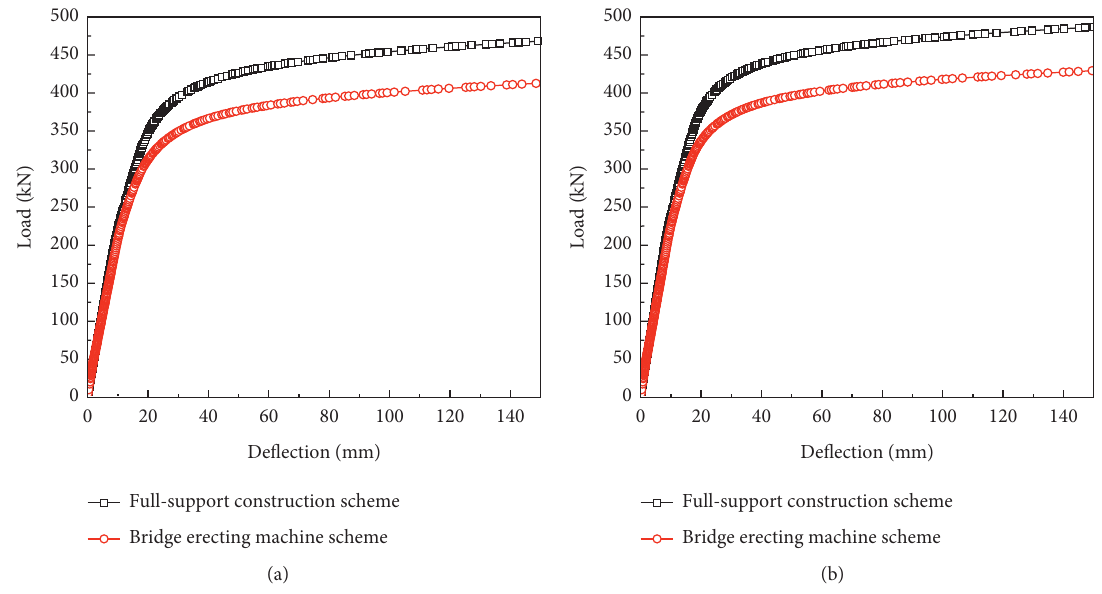
Figure 13: Load-deflection curves of curved TGCB models with different construction schemes: (a) outer girder; (b) inner